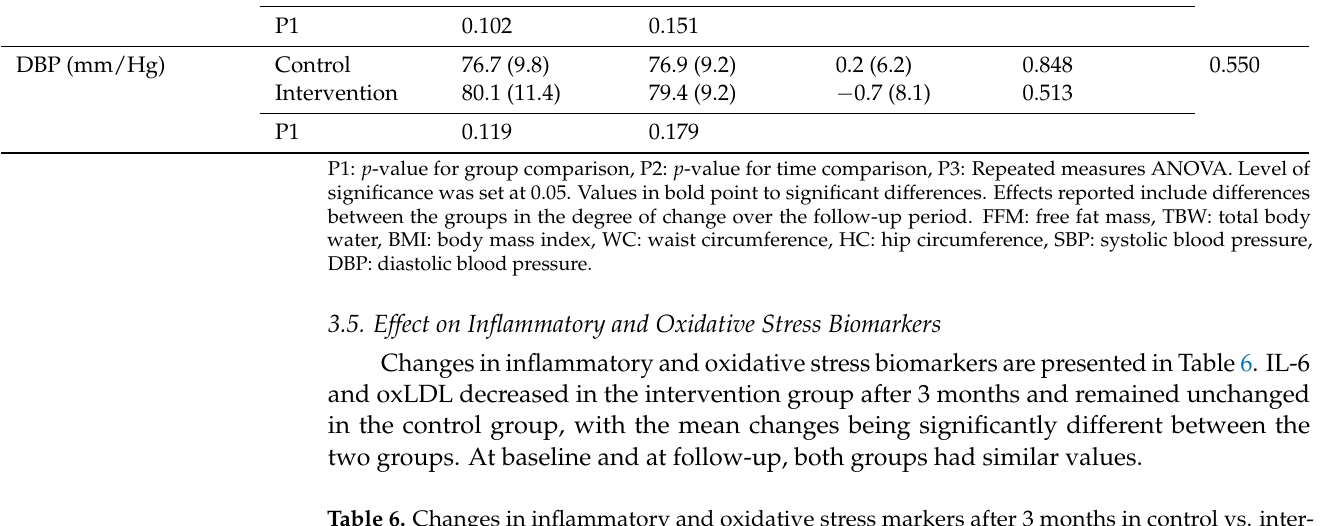
Table 6. Changes in inflammatory and oxidative stress markers after 3 months in control vs.